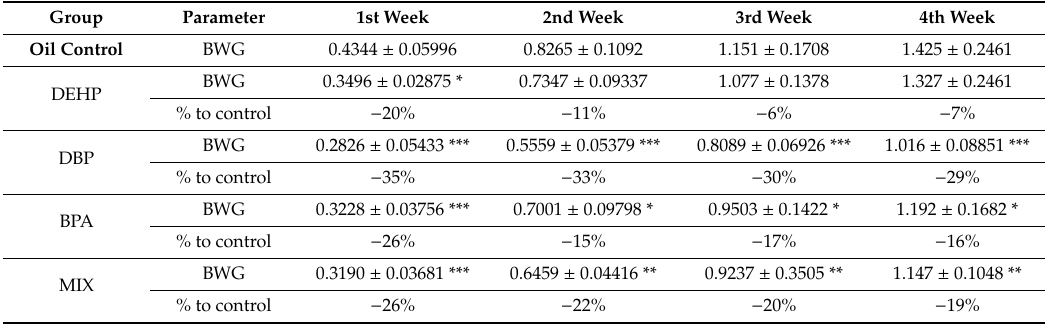
Table 1. Bodyweight gain in rats orally exposed to DEHP, DBP, BPA, and their mixture (MIX)